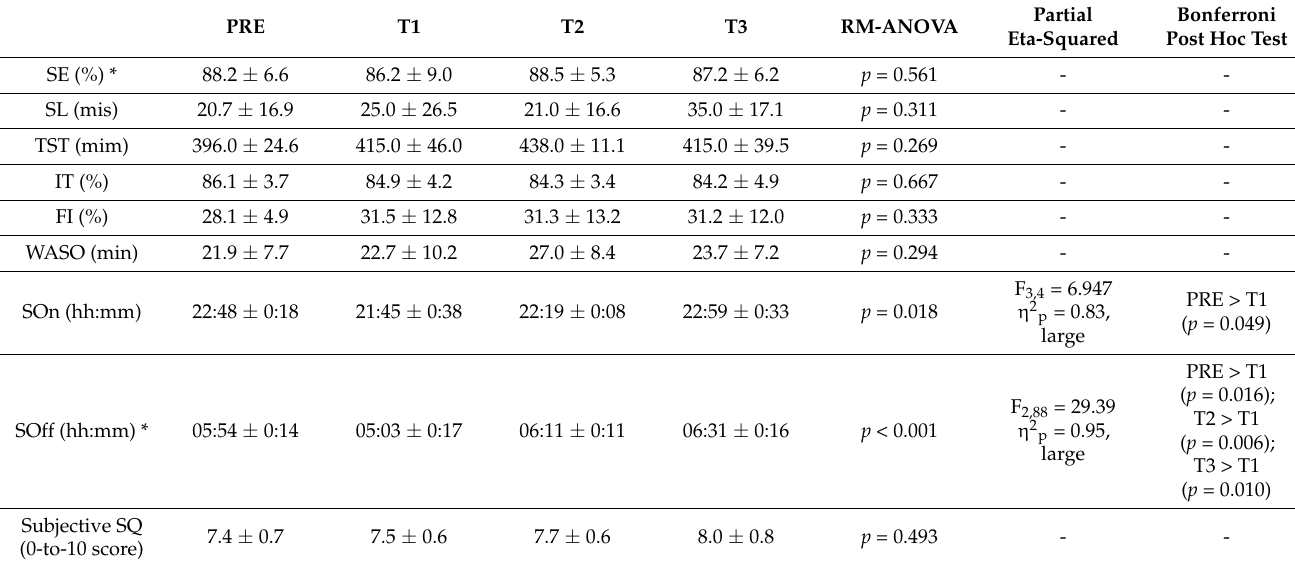
Table 1. Actigraphy-based sleep parameters and subjective sleep quality at PRE, T1, T2, and T3. Comparison among PRE, T1, T2, and T3 of sleep parameters. The data are reported as mean ± SD. *: SE and SOff were not normally distributed; therefore, the equivalent non-parametric Friedman test followed by Dunn’s multiple comparisons was